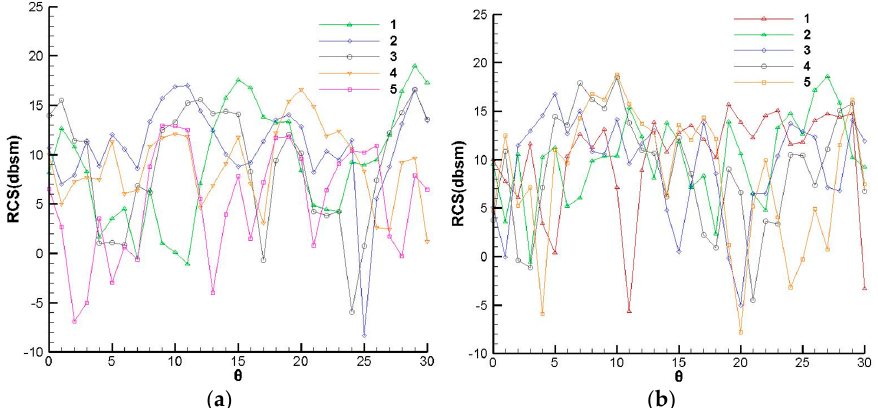
Figure 15. RCS values of sample points. ( a ) Horizontal polarization ( b ) Vertical polarization.